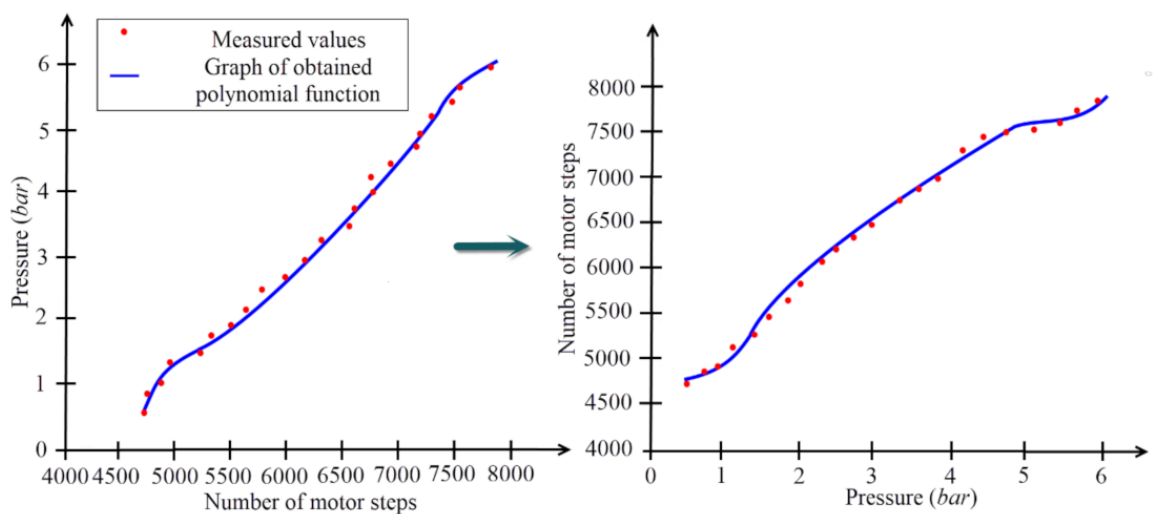
Figure 5. Transformation of polynomial function presenting the dependence of outlet pressure from number of steps of the stepper motor to the inverse polynomial function. Reproduced from [4], Springer: in